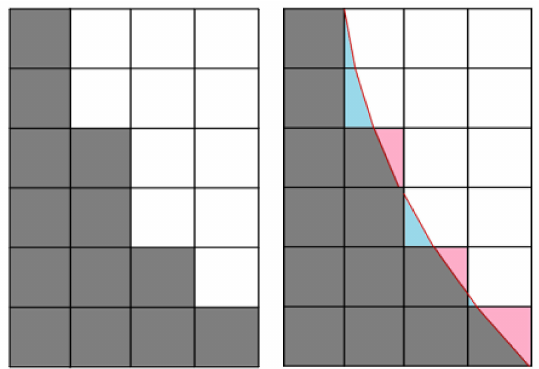
Figure 11. Example of application of smoothing technique. Before applying the smoothing technique ( left ); After applying the smoothing technique ( right